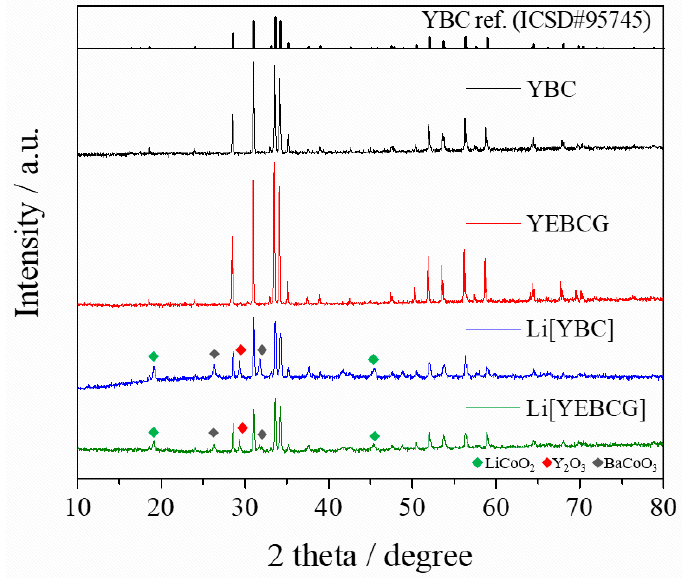
Figure 1. XRD patterns of pristine YBC and YEBCG, and their Li-intercalated forms of Li[YBC] and Li[YEBCG]. Table 1. Crystallographic parameters of YBC and YEBCG calculated by Rietveld refinement.